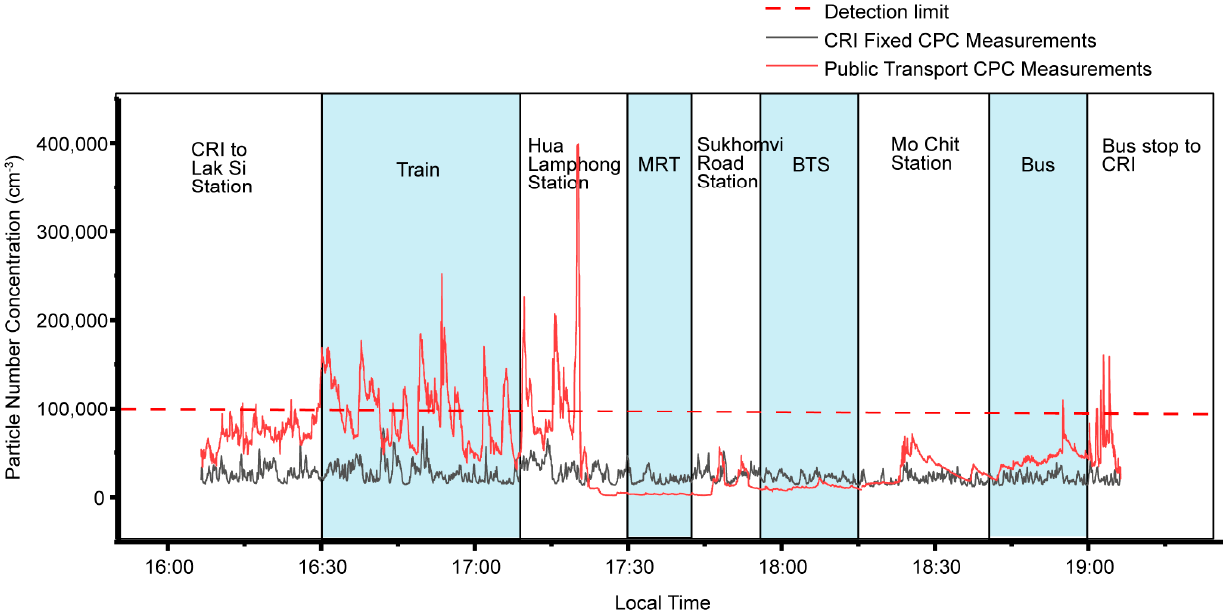
Figure 2. Example time series of particle number concentration on train, MRT, BTS and bus in Bangkok, compared with the particle number concentration measured at a single position. Values above the dotted line are above the limit of detection of the instrument and may be subject to undercounting. Walking and waiting are highlighted in white, while mass transit modes are highlighted in light blue.